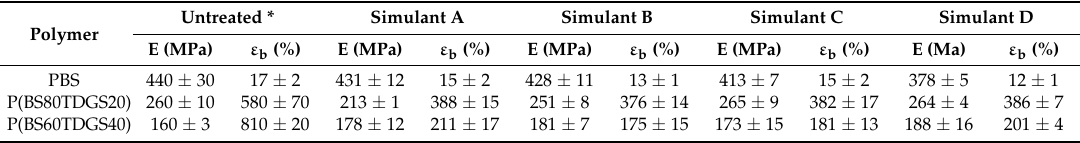
Table 6. Mechanical characterization data of PBS and P(BSxTDGSy) copolymers, after treatment with food